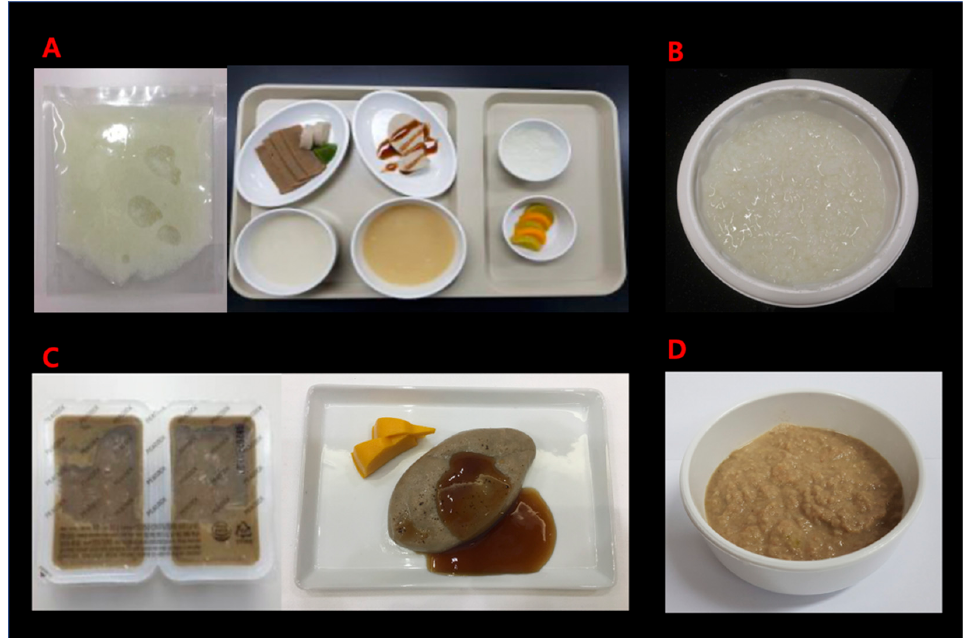
Figure 1. Study and control foods. ( A) rice gruel; ( B ) rice porridge; ( C ) bulgogi mousse; and ( D ) ground bulgogi.